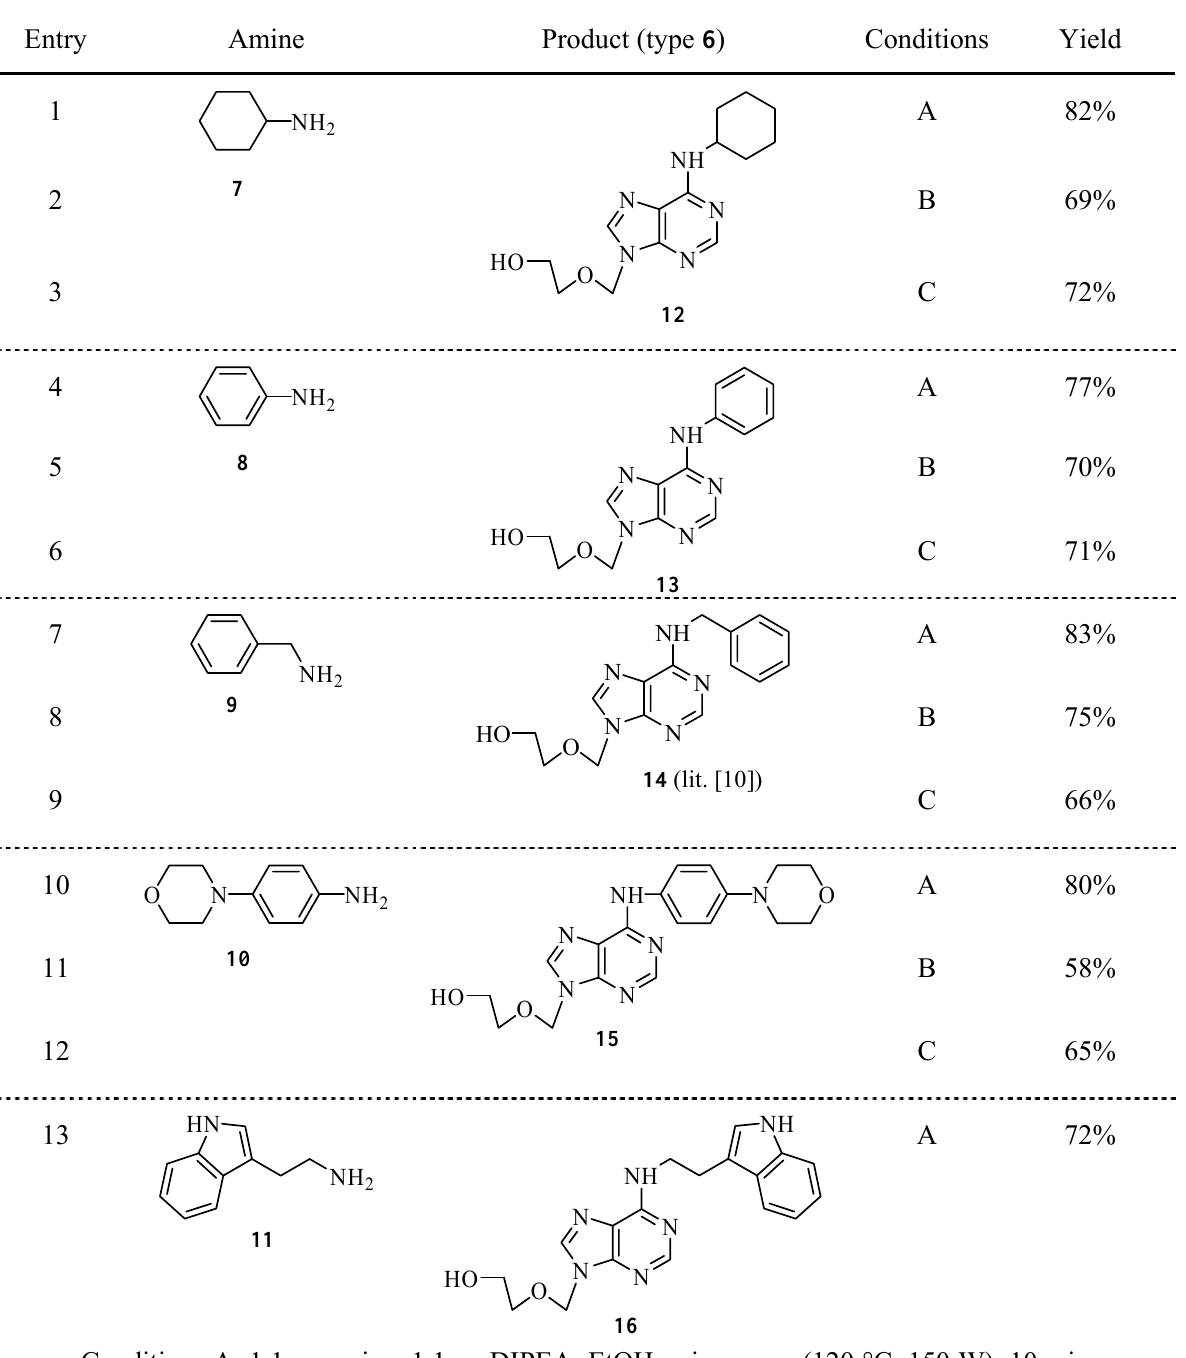
Table 1. Amination of 5 through nucleophilic